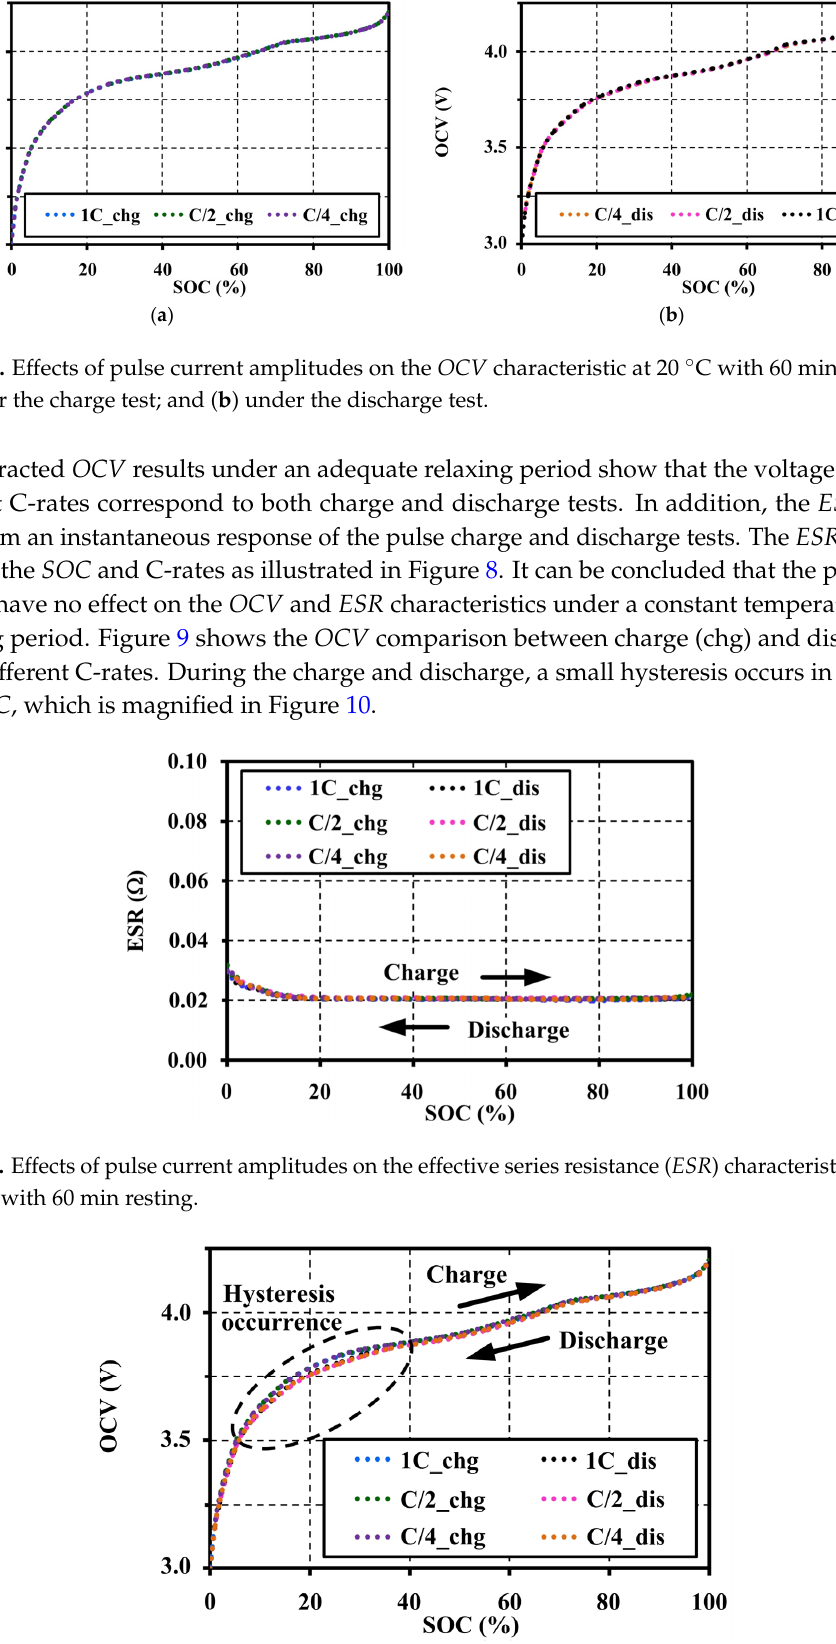
Figure 9. Hysteresis occurrence on the OCV characteristics tested at 20 °C with 60 min resting.